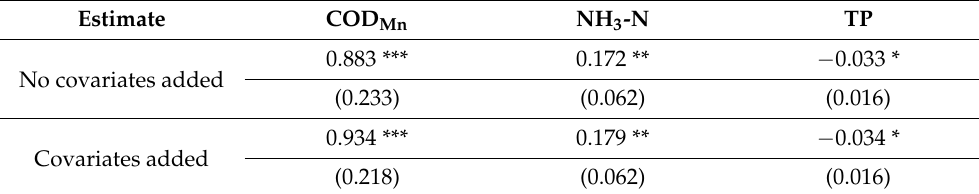
Table 6. Regression discontinuity estimation